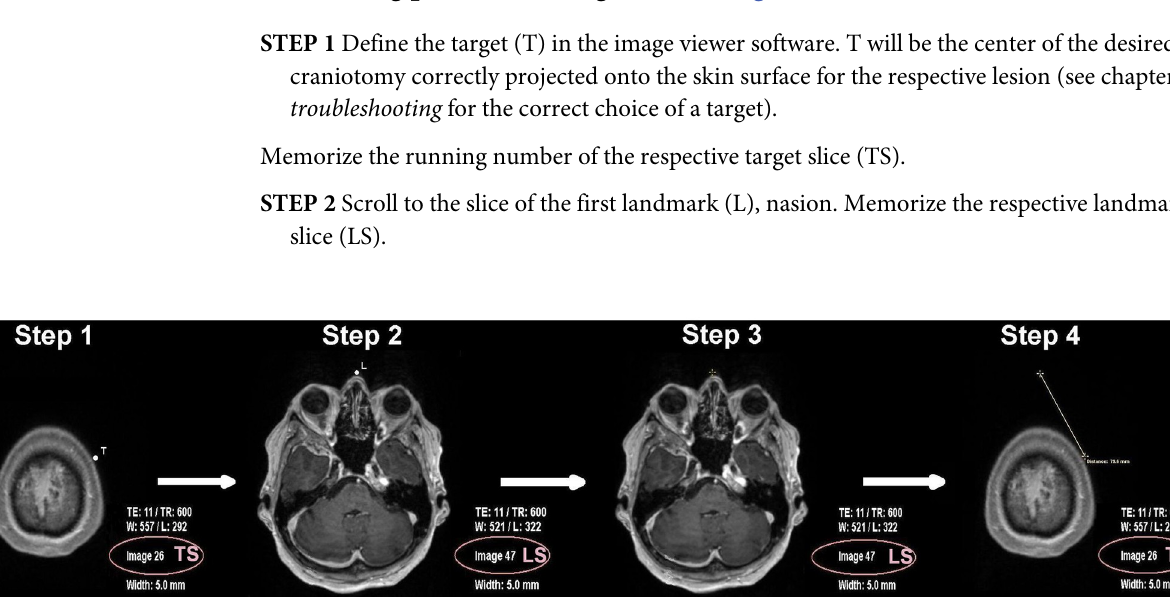
PLOS ONE | https://doi.org/10.1371/journal.pone.0251023 May 20,